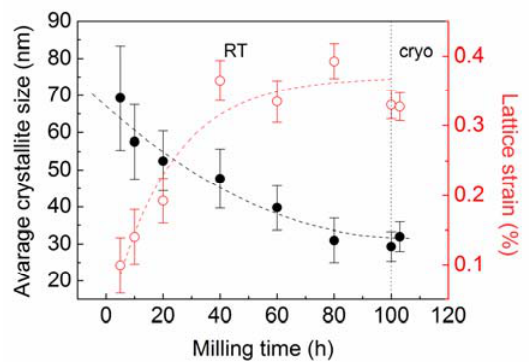
Figure 4. Average crystallite size (full symbols) and lattice strain (open symbols) for the hcp Mg phase as a function of the milling